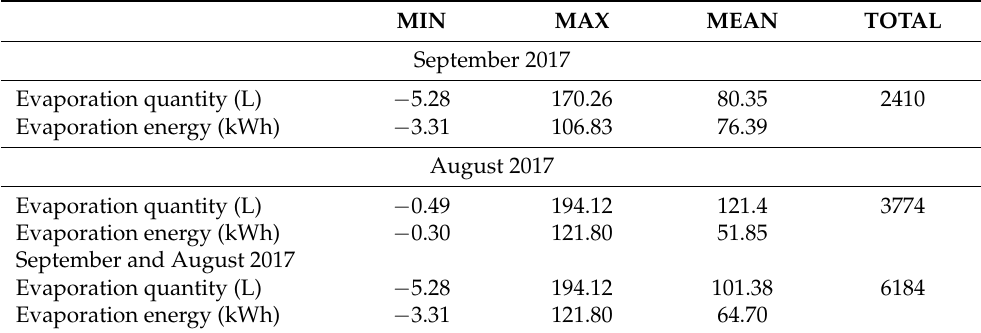
Table 1. MIN, MAX and MEAN values of evaporation amount and evaporation energy in September and August